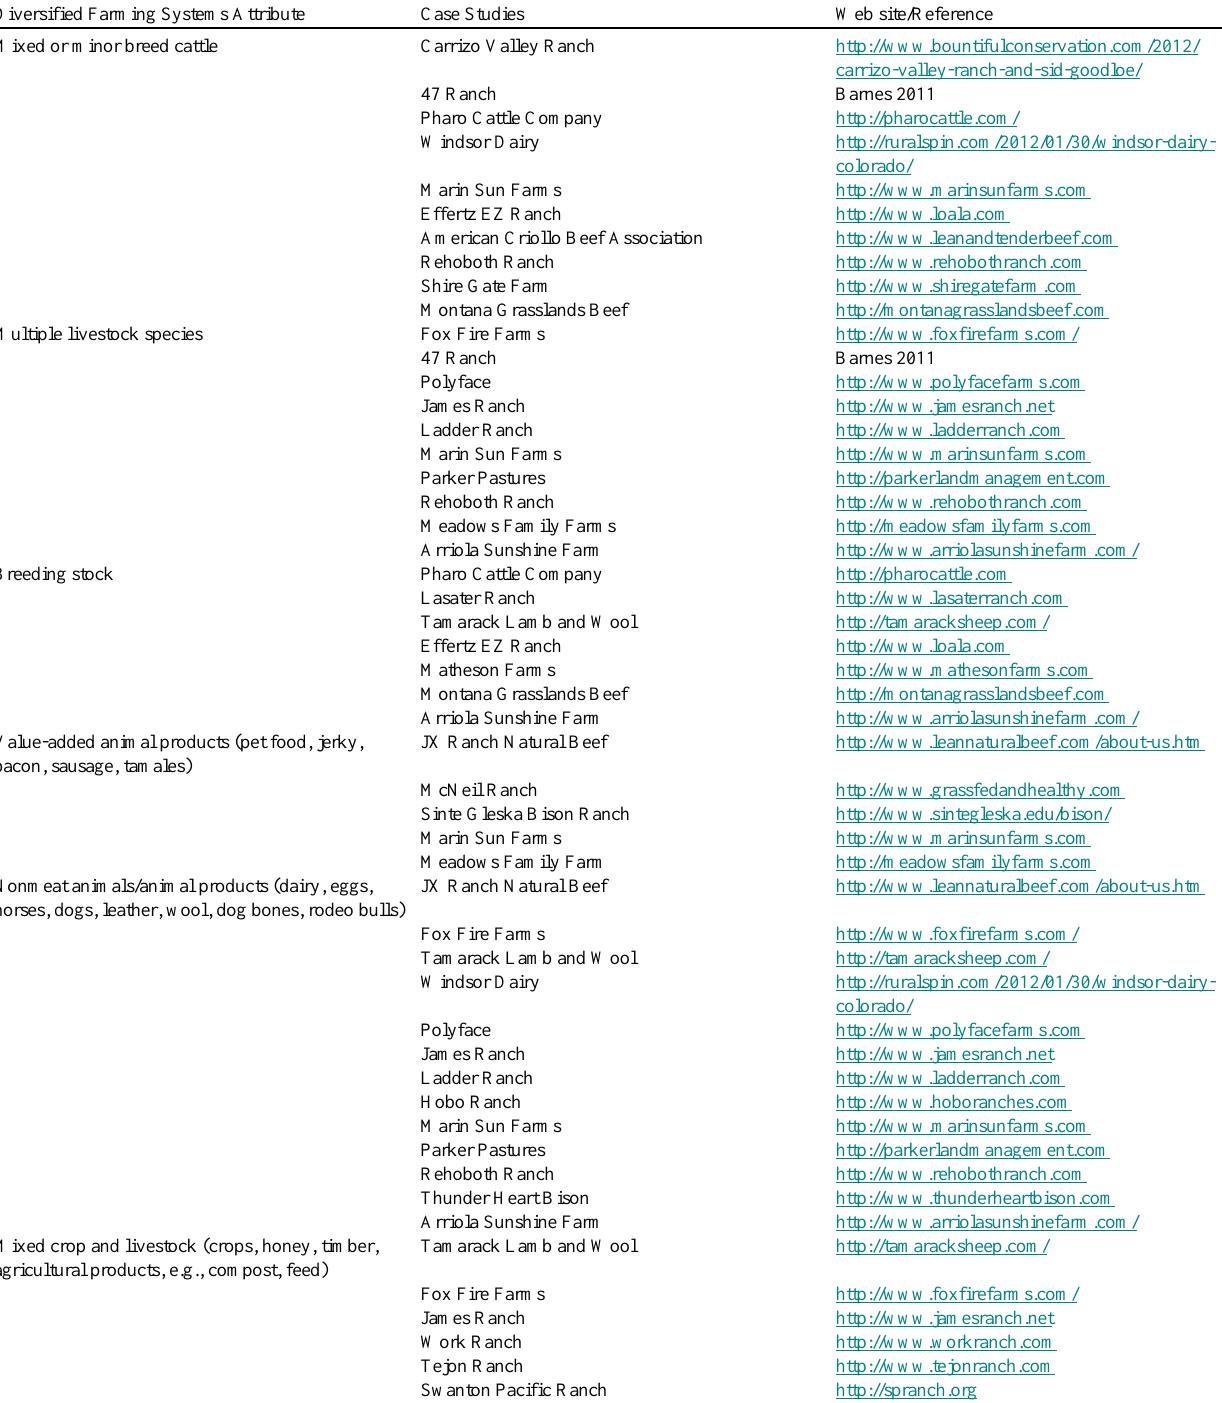
Table 3 . Diversification of